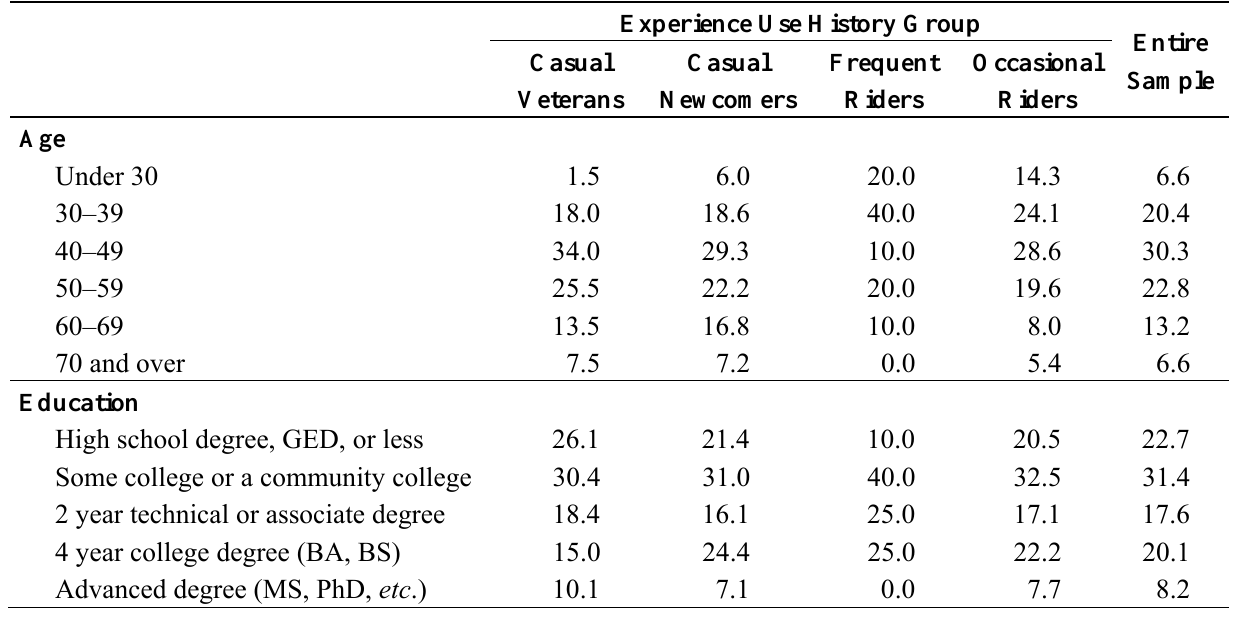
Table 2. Socio-demographic characteristics of off-highway vehicle owners by EUH